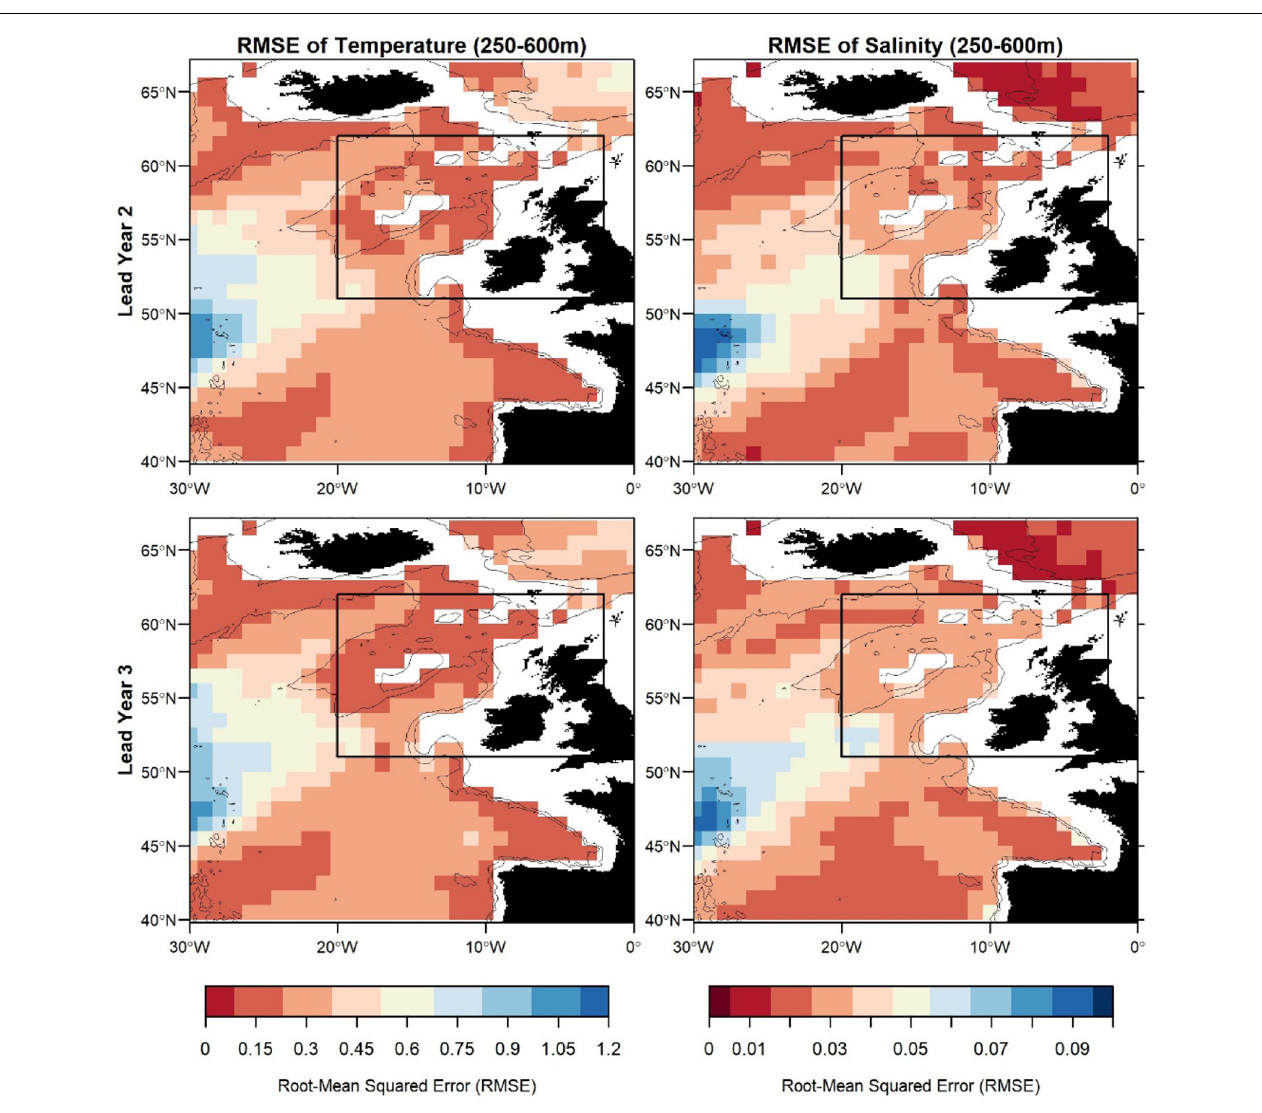
FIGURE 7 | Root-mean squared error (RMSE) of temperature (left) and salinity (right) in FMA at lead year 2 ( ≈ 16 months) (top) and lead year 3 ( ≈ 28 months) (bottom) comparing MPI-ESM-hindcast to MPI-ESM-assim . The black rectangle delineates the study area: the spawning region of blue